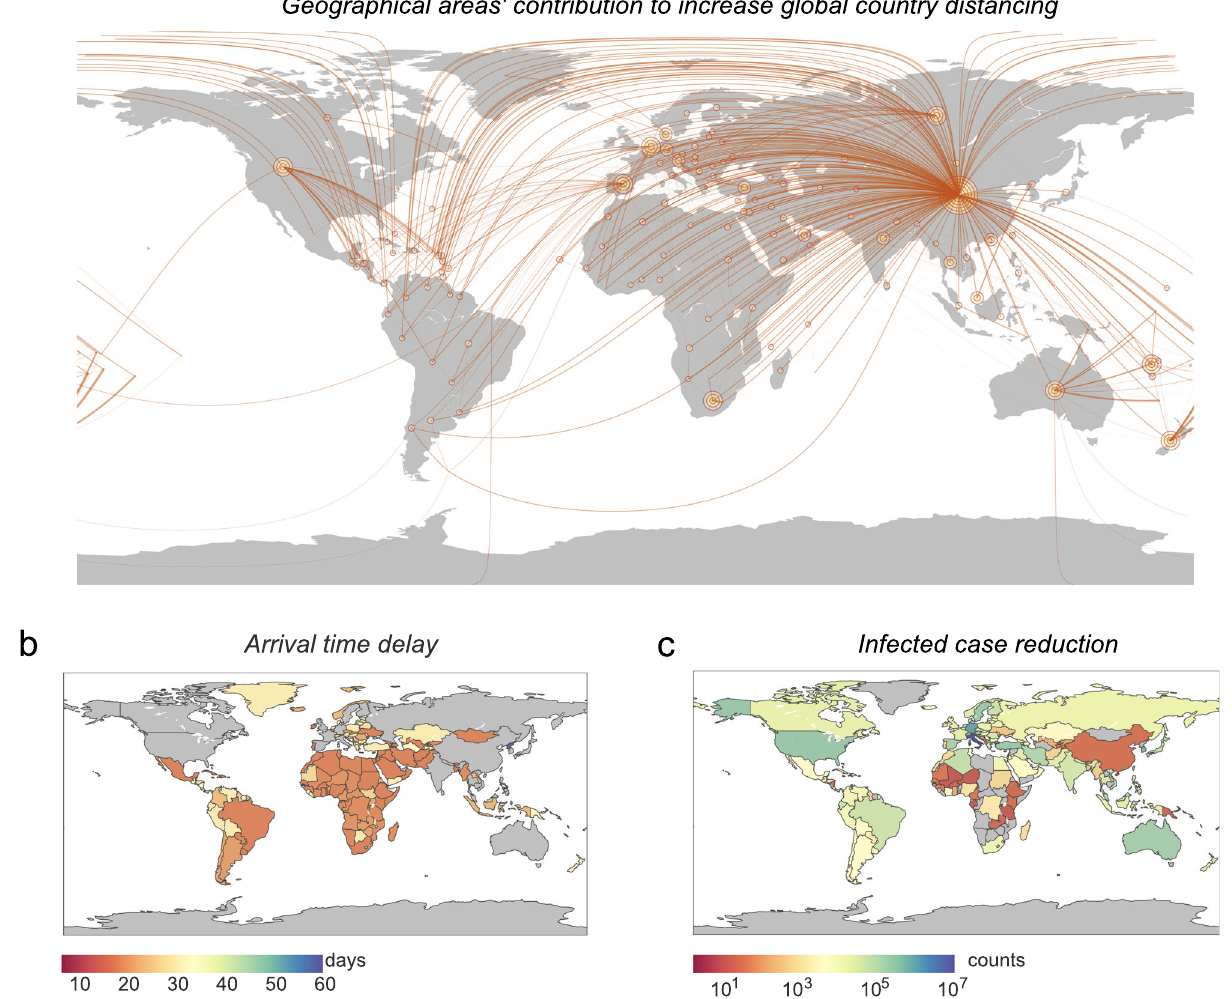
Fig. 6 Geographical areas ’ contributions and gains in terms of arrival time delay and infected case reduction. According to existing travel restrictions until 1 June 2020, ( a ) geographic areas contributed to increasing other countries ’ distances from the outbreak locations. The size of the circle in each area is proportional to its contribution to the global country distancing increase. The curved lines depict the distancing from one area to the destination area. b , c show the geographic areas ’ gains in terms of days of arrival time delay and counts of infected case